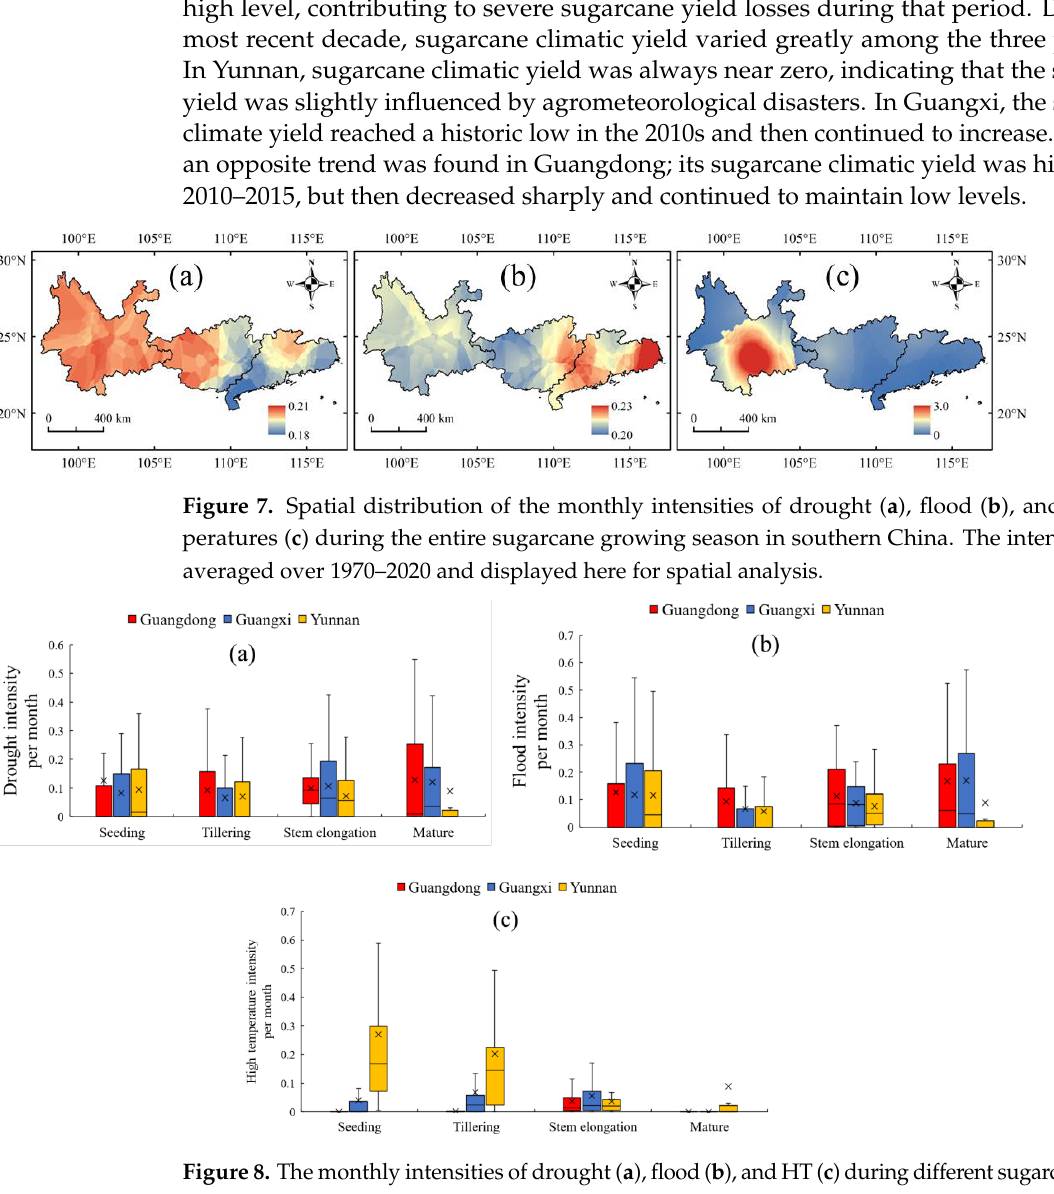
Figure 8. The monthly intensities of drought ( a ), flood ( b ), and HT ( c ) during different sugarcane growth stages in southern China. × and — in the boxes represent the mean and median values, respectively.